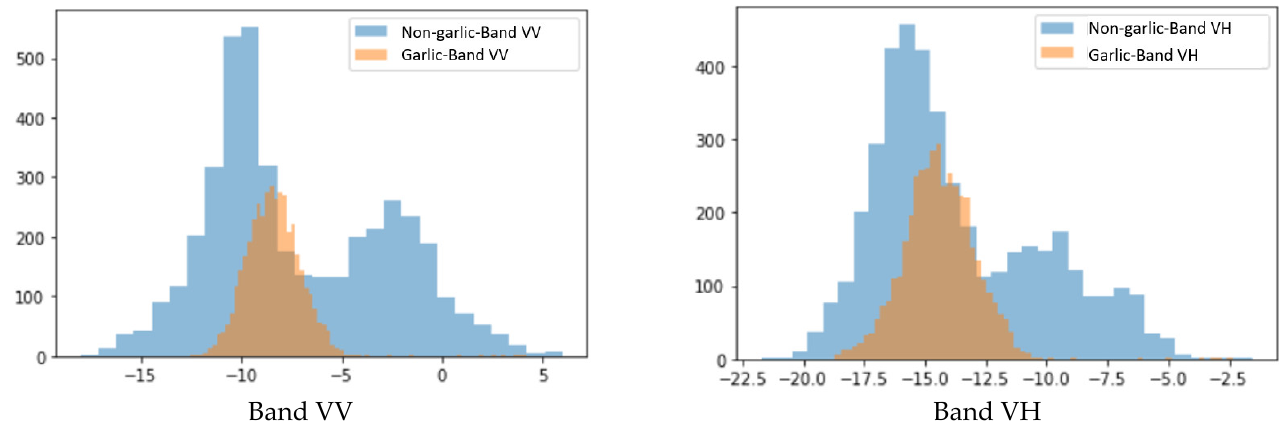
Figure 5. Histograms of the two classes in the VV and VH bands (decibel (dB)) of Sentinel-1A images [35]. Table 15. Kappa value of classification models generated using the k -NN and MLC methods.